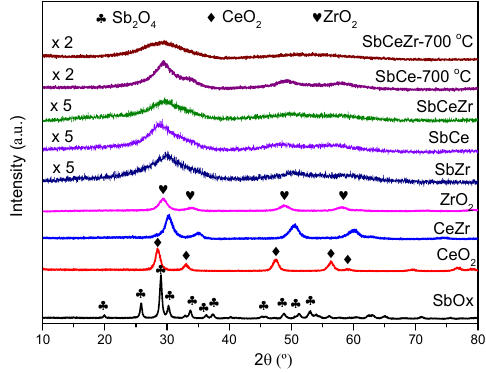
Figure 3. XRD patterns of the catalysts.